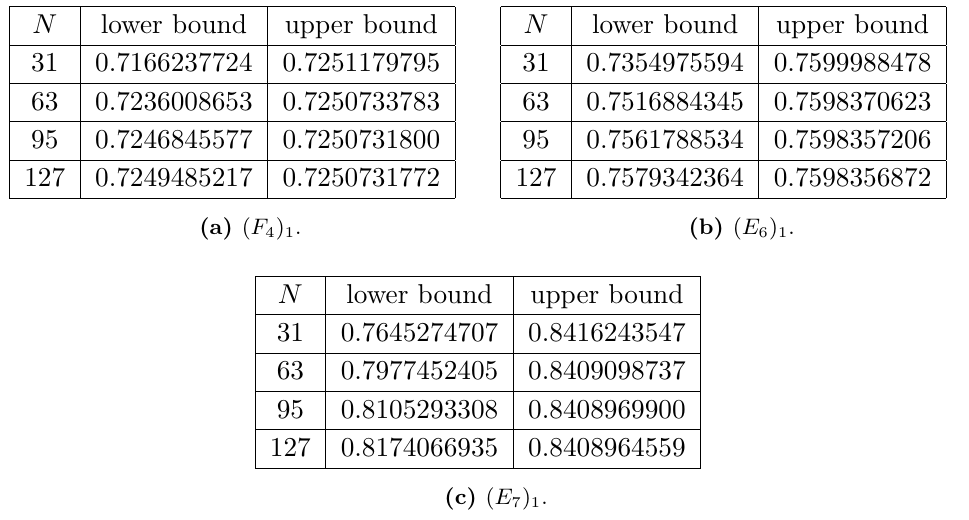
Table 9. Upper and lower bounds on the g -function for stable boundary conditions in the ( F 4 ) 1 (top left), ( E 6 ) 1 (top right), and ( E 7 ) 1 (bottom) WZW models obtained at various derivative orders N , with the information of the first 100 bulk scalars incorporated into the crossing equation. The √ 5 bounds are potentially convergent upon ( 1 − ) 1 / 4 , 3 − 1 / 4 and 2 − 1 / 4 , which are also the unique 2 10 g -functions for stable boundaries in the ( G 2 ) 1 , SU(3) 1 and SU(2) 1 WZW models,